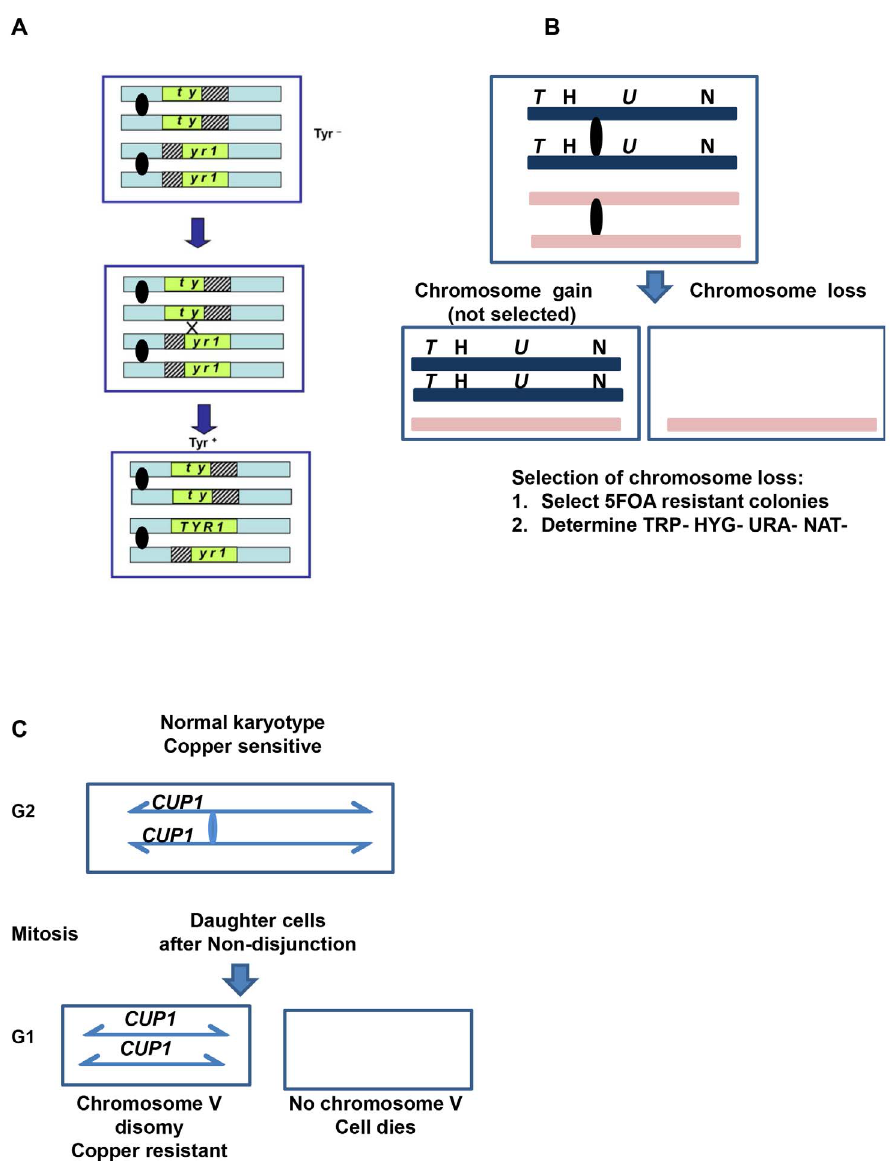
Fig. 1. Genetic assays. A. Allelic recombination assay (previously described in [14,16]). The two homologs of chromosome II in a diploid strain have truncations in the TYR1 gene with 300 nucleotide overlaps such that recombination generates Tyr + cells capable of growth on medium lacking tyrosine. B. Chromosome loss and loss of heterozygosity (LOH) assays, described under Material and Methods in "Determination of the rates for the different genome instability events". Briefly, the assay selects first for cells that are resistant of 5FOA due to loss of URA3 gene function, primarily from LOH. The 5FOA resistant colonies were then analyzed for loss of the hyg, nat and TRP1 markers. C. Chromosome gain assay (described in details under Materials and Methods "Determination of the rates for the different genome instability events"). The chromosome gain rate was determined from the number of colonies arising on copper-containing medium. Resistance is due to an increase in CUP1 copies which is primarily due to chromosome gain as was shown in [15].